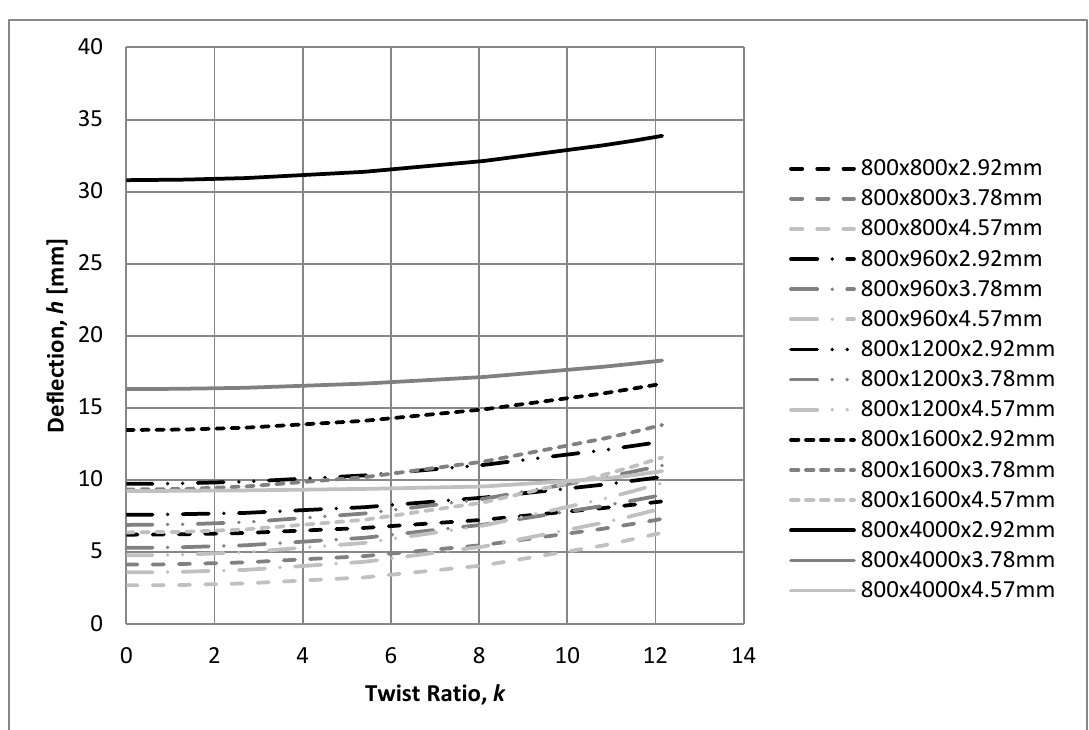
Fig. 7 Transverse deflection of 800mm wide specimens at 1.0